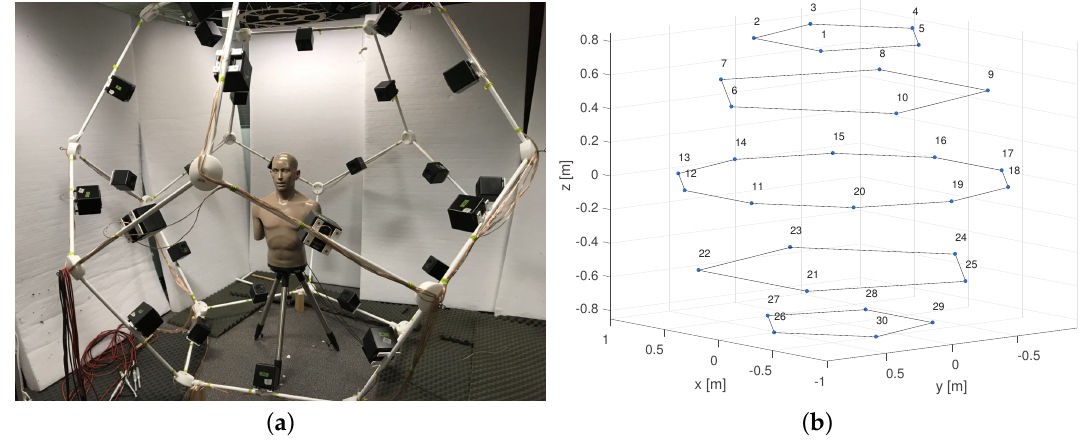
Figure 11. The hardware setup and the loudspeaker positions. ( a ) The loudspeakers are positioned on the middle of edges of a dodecahedron frame, and the dummy head simulator with two microphones are placed in the center of the speaker arrays; ( b ) The ground truth position of sound sources and their